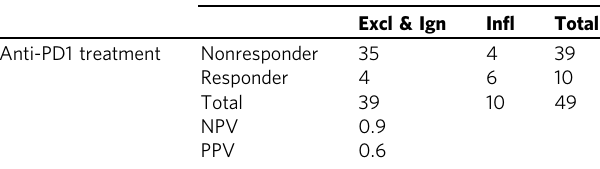
Table 3 Clinical validation of gene classi fi er. Gene classi fi er (as described in Results section and Fig. 2a) was tested for prediction of response to anti-PD1 treatment. PPV positive predictive value, NPV negative predictive